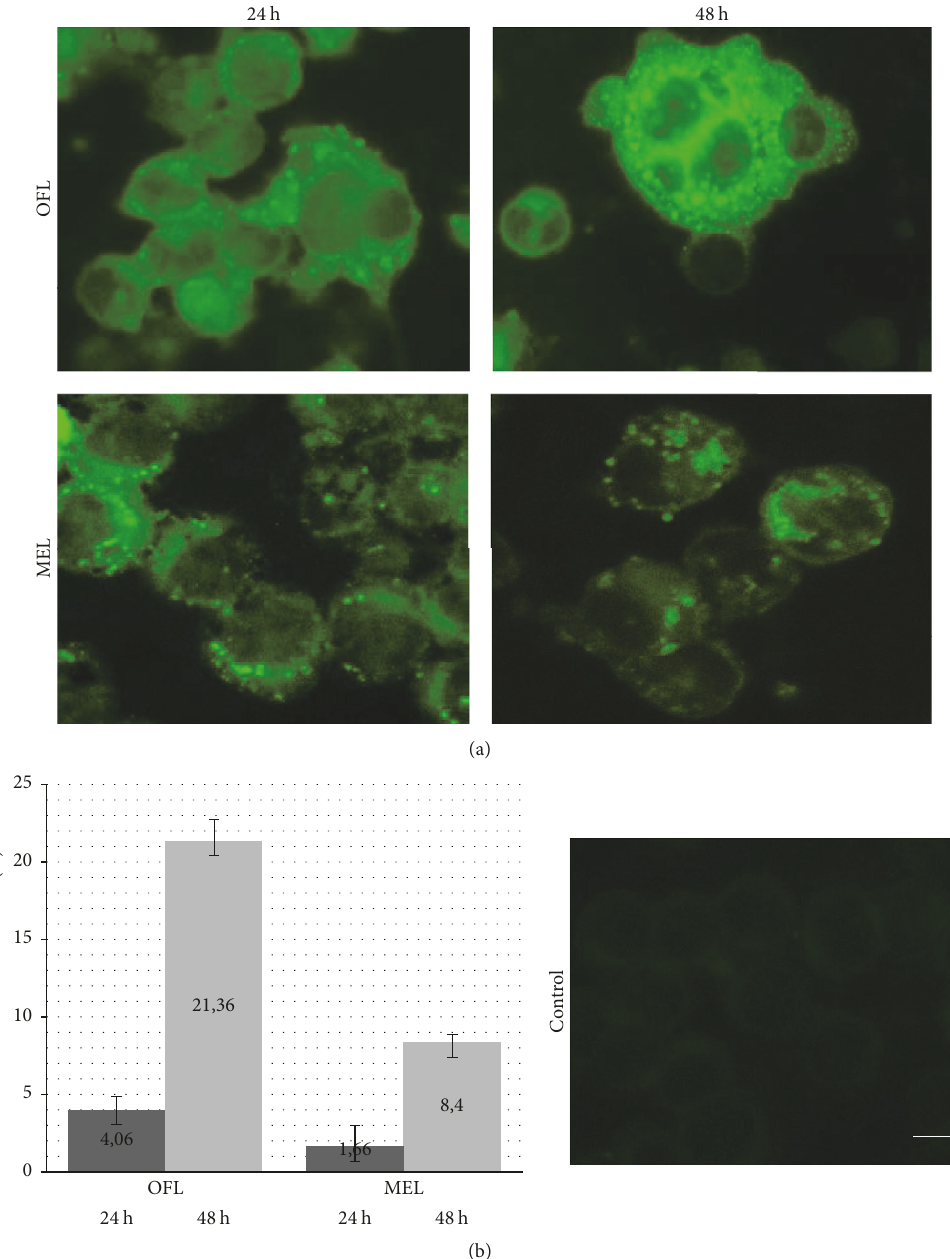
Figure 1: Lycopene induces formation of lipid droplets in B10.MLM cells. (a) Cells were stained with fluorescent dye BODIPY in 24 and 42 hours after lycopene addition; (b) ratio of lipid droplet area to cell area was estimated with automatic image processing method. OFL: oil-formulated lycopene and MEL: microencapsulated lycopene. Scale bar 10 𝜇